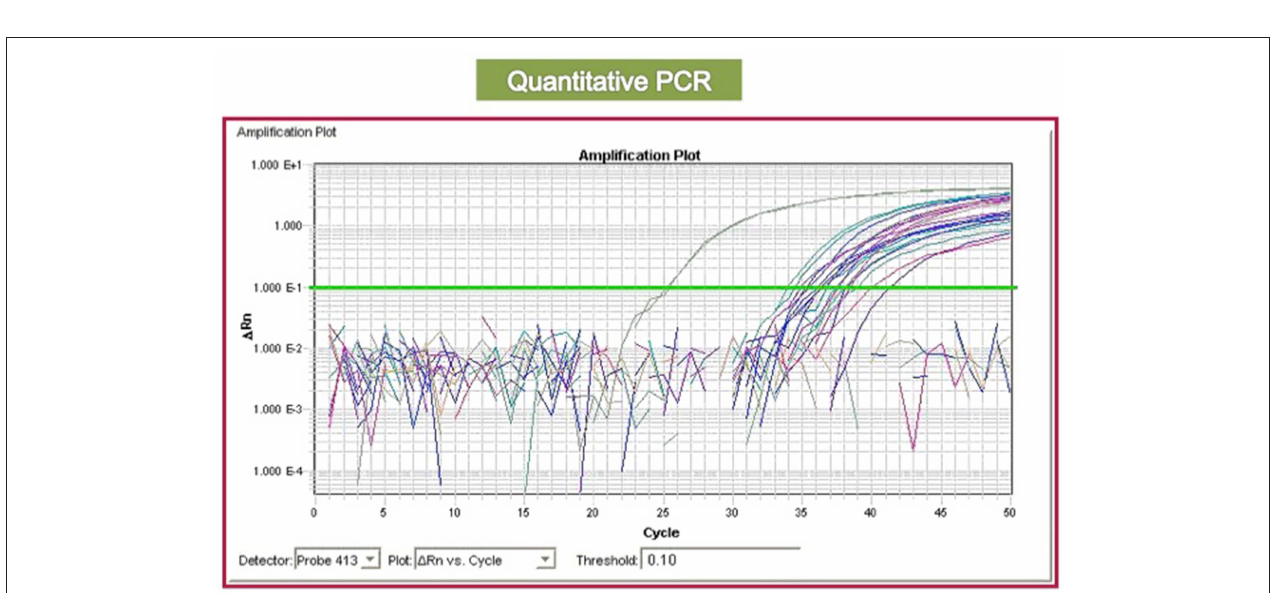
FIGURE 1 | The figure represents the most frequent loci of rupture of the BCR and ABL1 genes (up part) and the consequently origined proteins (P190, P210, P230, rare rearrangements) taken from Weerkamp et al. (7).